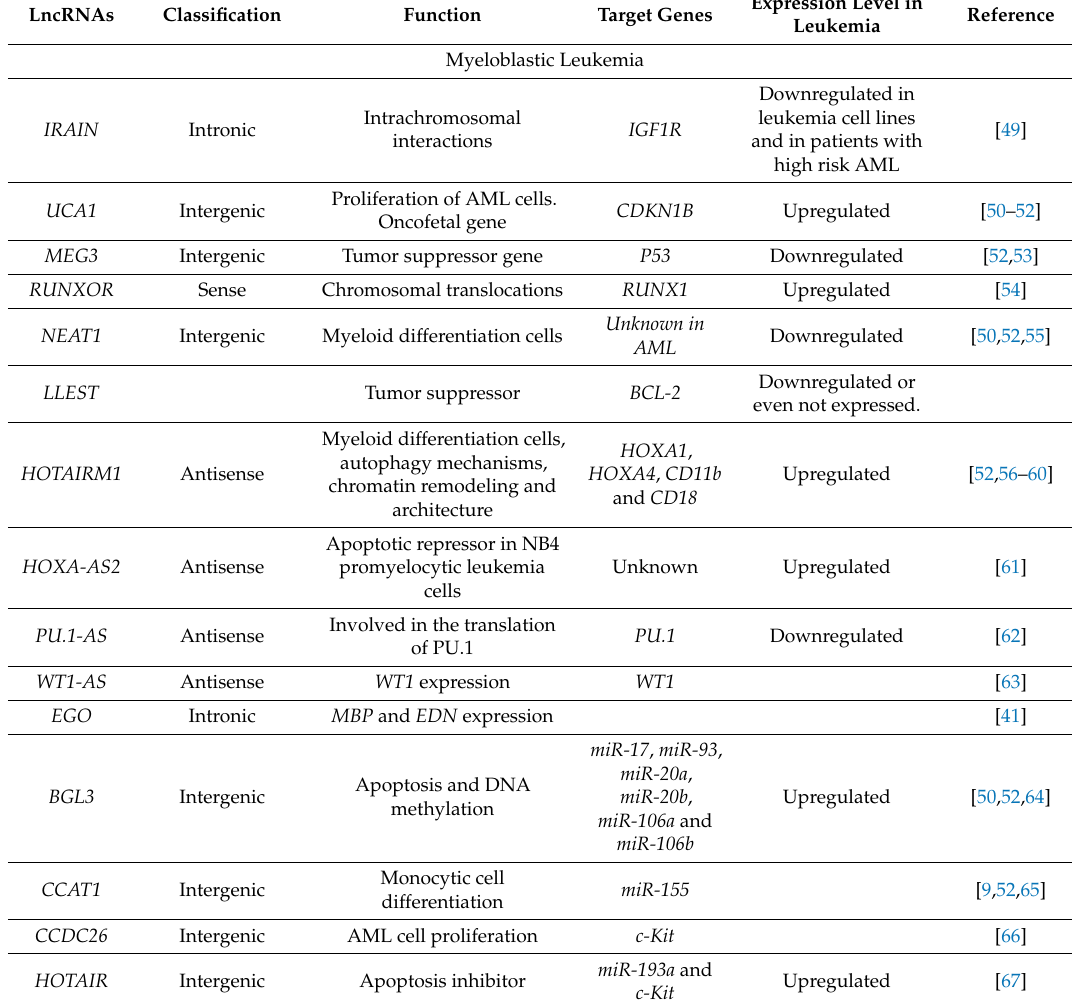
Table 2. Examples of lncRNAs described in acute